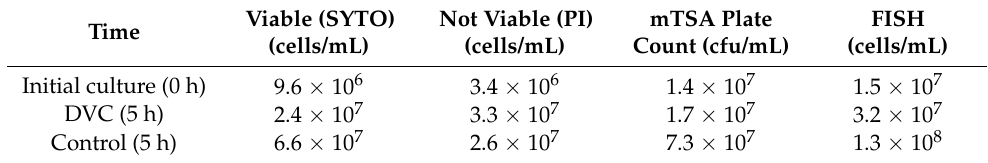
Table 1. Results of culture viability using the LIVE/DEAD BacLight